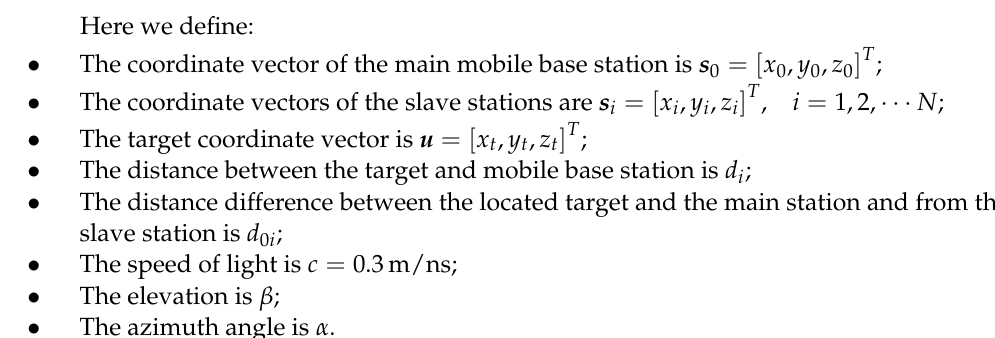
Figure 3. TDOA and AOA 3D passive positioning model.